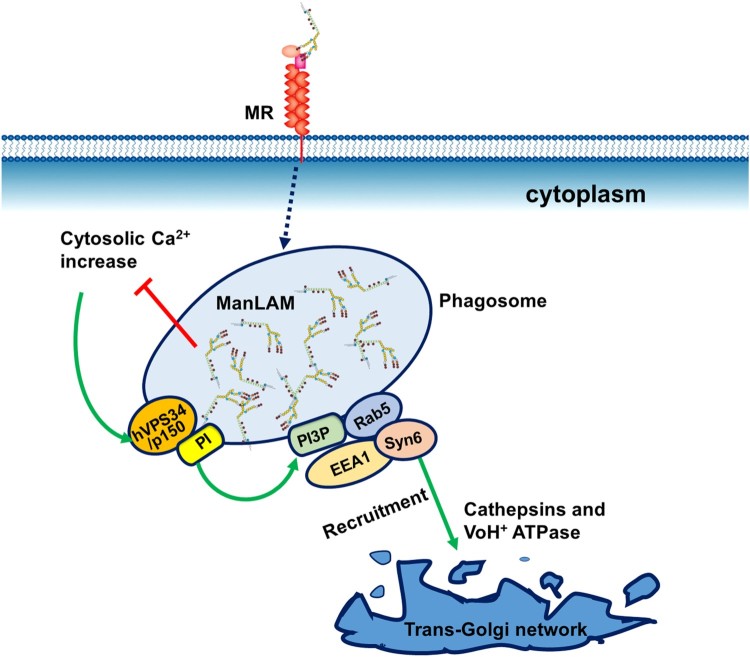
Inhibition of phagosome maturation by ManLAM. The phagosome-lysosome fusion process is classically dependent on cytosolic Ca2+ increase. Ca2+/calmodulin-dependent PI3-kinase hVPS34 and its modulatory subunit p150 generate phosphatidylinositol 3-phosphate (PI3P) on the phagosomal membrane. PI3P mediates the recruitment of the membrane tethering protein early endosome autoantigen 1(EEA1) to the phagosome. EEA1 is essential for phagosome maturation by directly interacting with syntaxin-6 (Syn6), which is involved in the delivery of cathepsins (lysosomal hydrolases) and VoH1-ATPase from the trans-Golgi network to the phagosome. ManLAM inhibits cytosolic-Ca2+ increase and thereby blocks the successive steps, resulting in the prevention of lysosomal fusion and acidification.